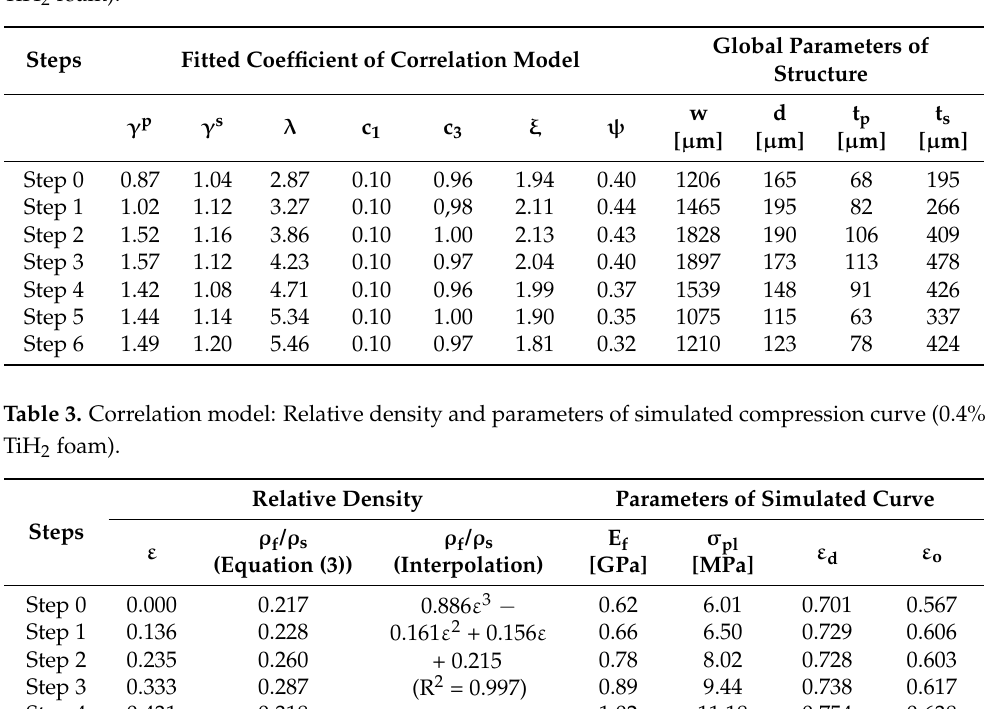
Table 2. Correlation model: Fitted coefficients and global parameters of cellular structure (0.4% TiH 2 foam).